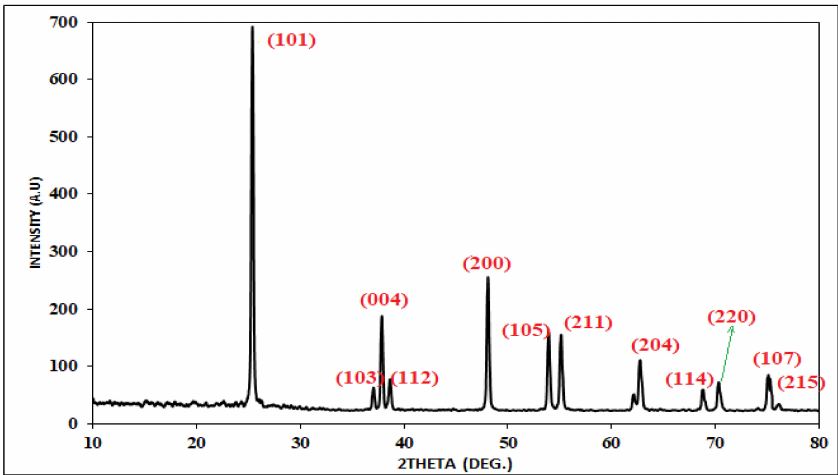
Figure 10. XRD patterns of the TiO 2 nanoparticles.